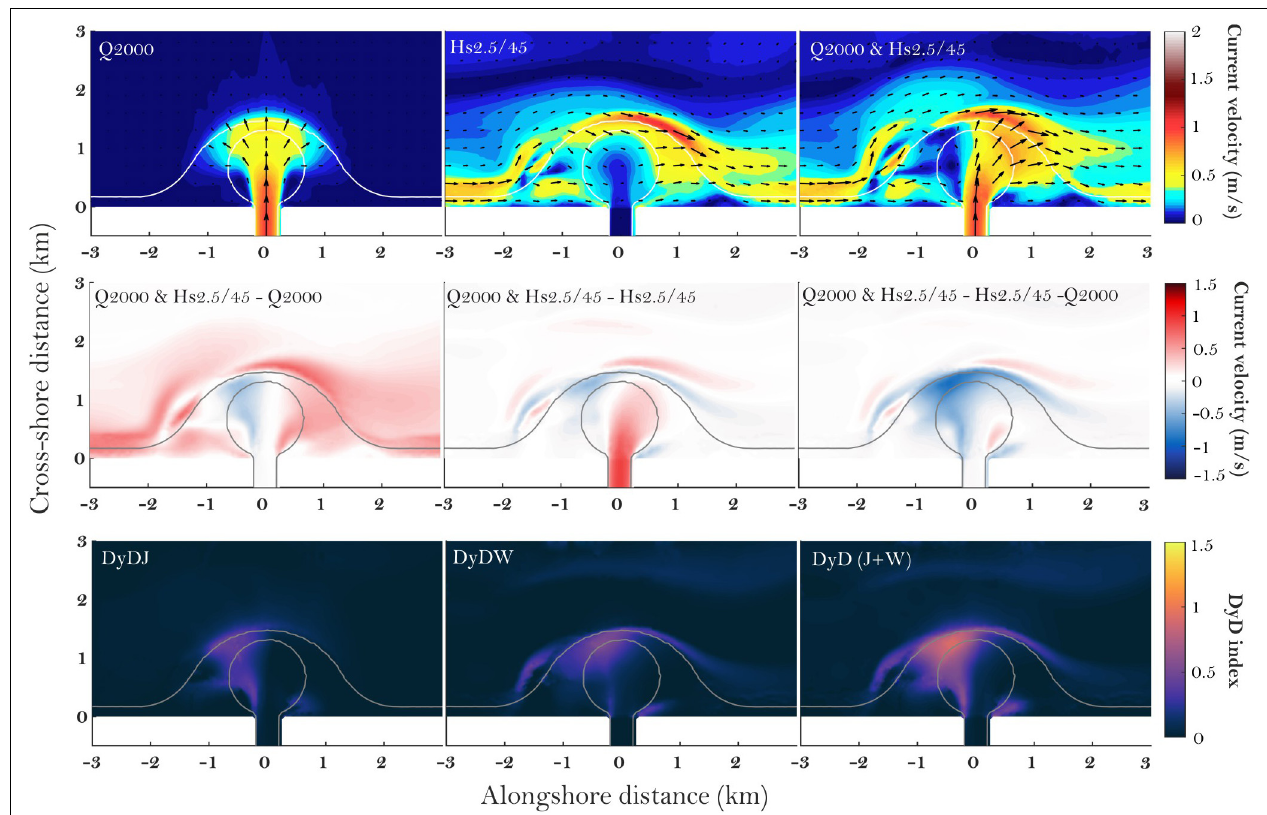
FIGURE 12 | Relation of the DyD (bottom) to current velocities (top), and differences between current velocity fields (middle) for the Big RMB